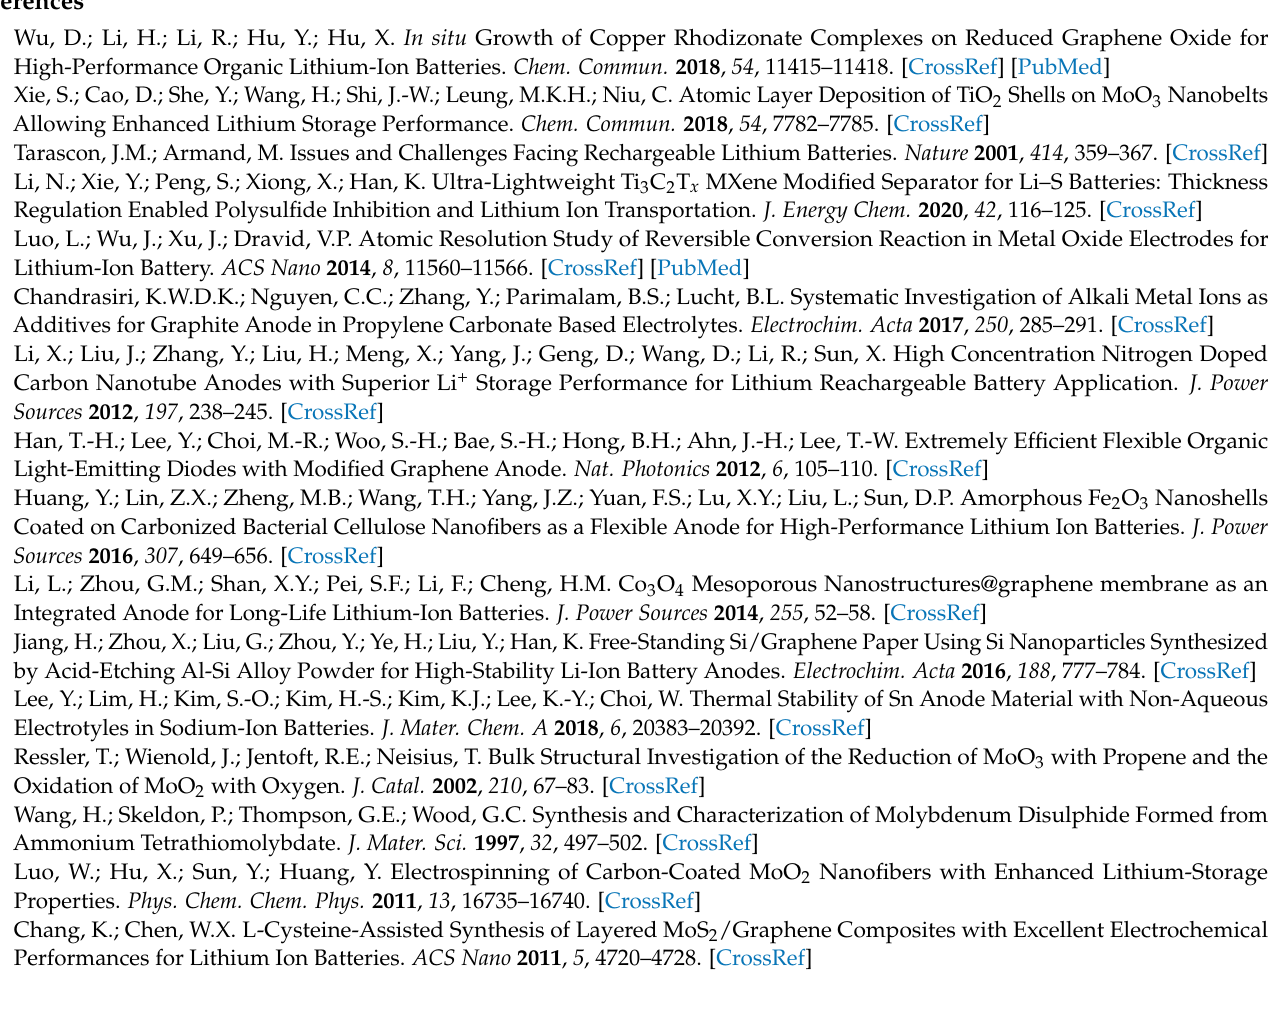
Figure S1: (a) XPS survey spectrum of AMT and AMT/PDA, (b) High-resolution XPS spectrum of Mo 3d of AMT and AMT/PDA. Figure S2: Cross-sectional SEM images of (a) Freeze dried AMT, (b) AMT/PDA. Statistical data of length (c) and width (d) for AMT/PDA flake. Figure S3: Cyclic voltammetry curves of (a) AMT and (b) freeze dried AMT electrodes. Figure S4: (a) Rate capability and (b) cycling performances of the PDA electrode. Figure S5: Long-term cycling performances of AMT, freeze dried AMT, and AMT/PDA electrodes. Figure S6 : Charge/discharge voltage profiles of (a) AMT and (b) AMT/PDA during long-term